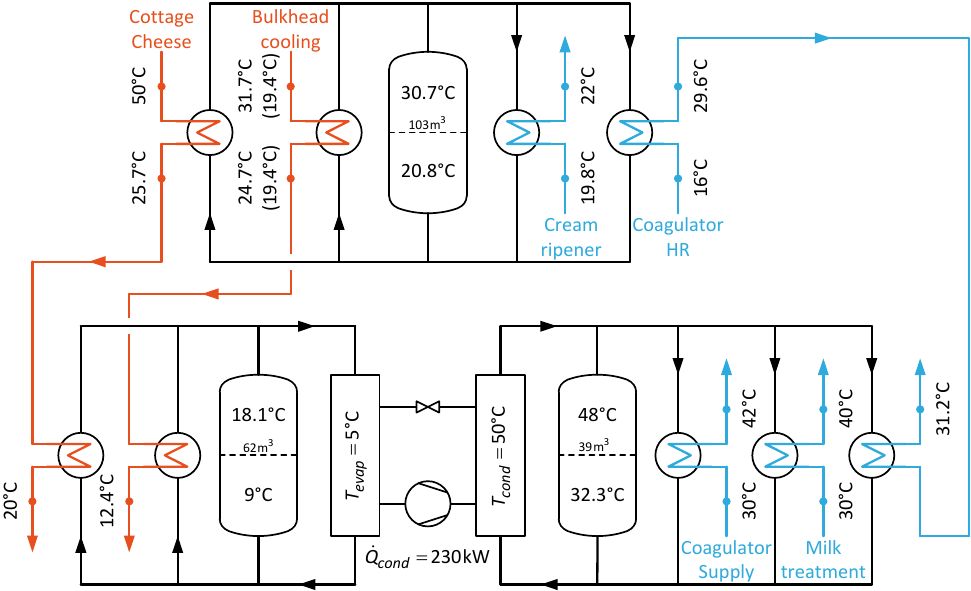
Figure 13. Schematic of solution Variant 2: Split IHR and HP system with 1700 kWh IHR.